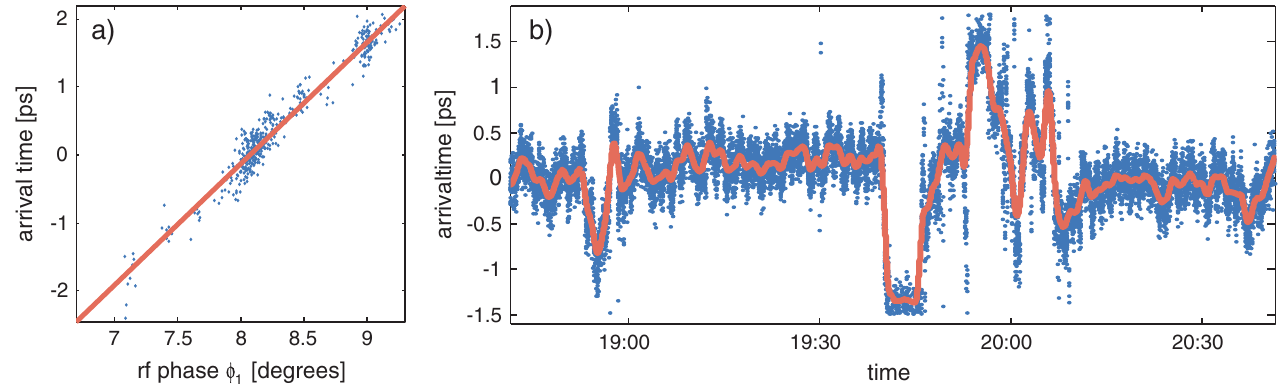
FIG. 19. (Color) (a) Correlation between arrival time and rf phase (cid:9) The slope is 1 : 79 ps = degree . (b) Arrival time of the electron bunch at the EO experiment measured during SASE tuning. The red line shows the slow